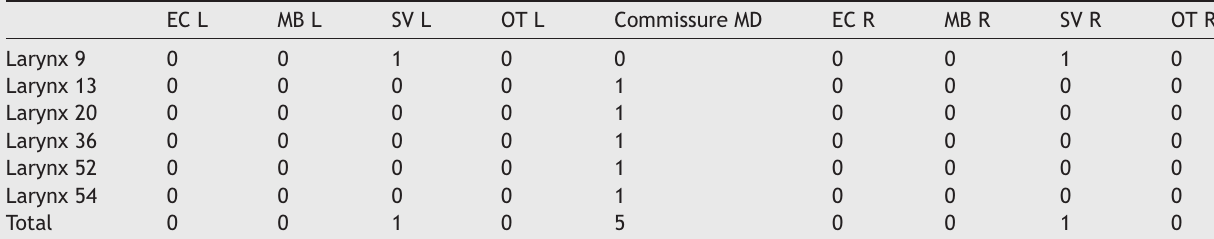
Numerical distribution of minor structural alterations found in six larynxes, regarding type and location, left or right vocal fold, and commissure ( n =